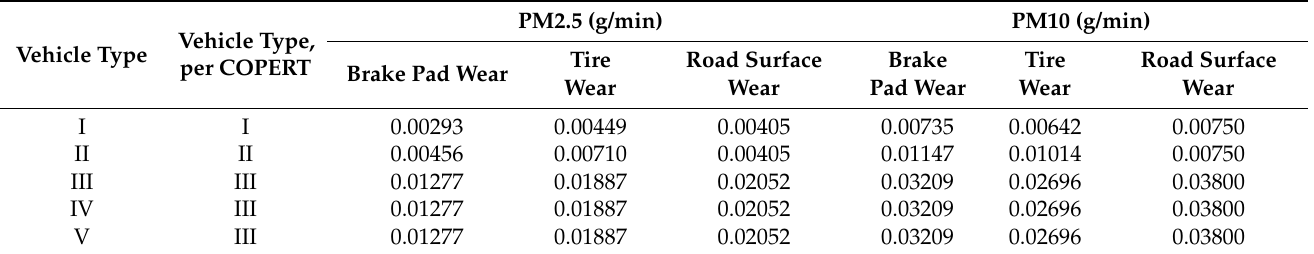
Table 4. Specific running coefficients by types of vehicles